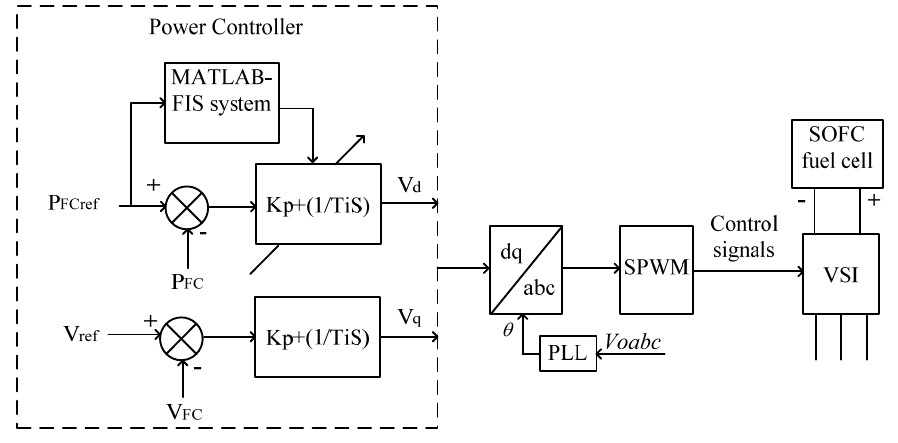
Figure 5. Solid oxide fuel cell (SOFC) active power control.